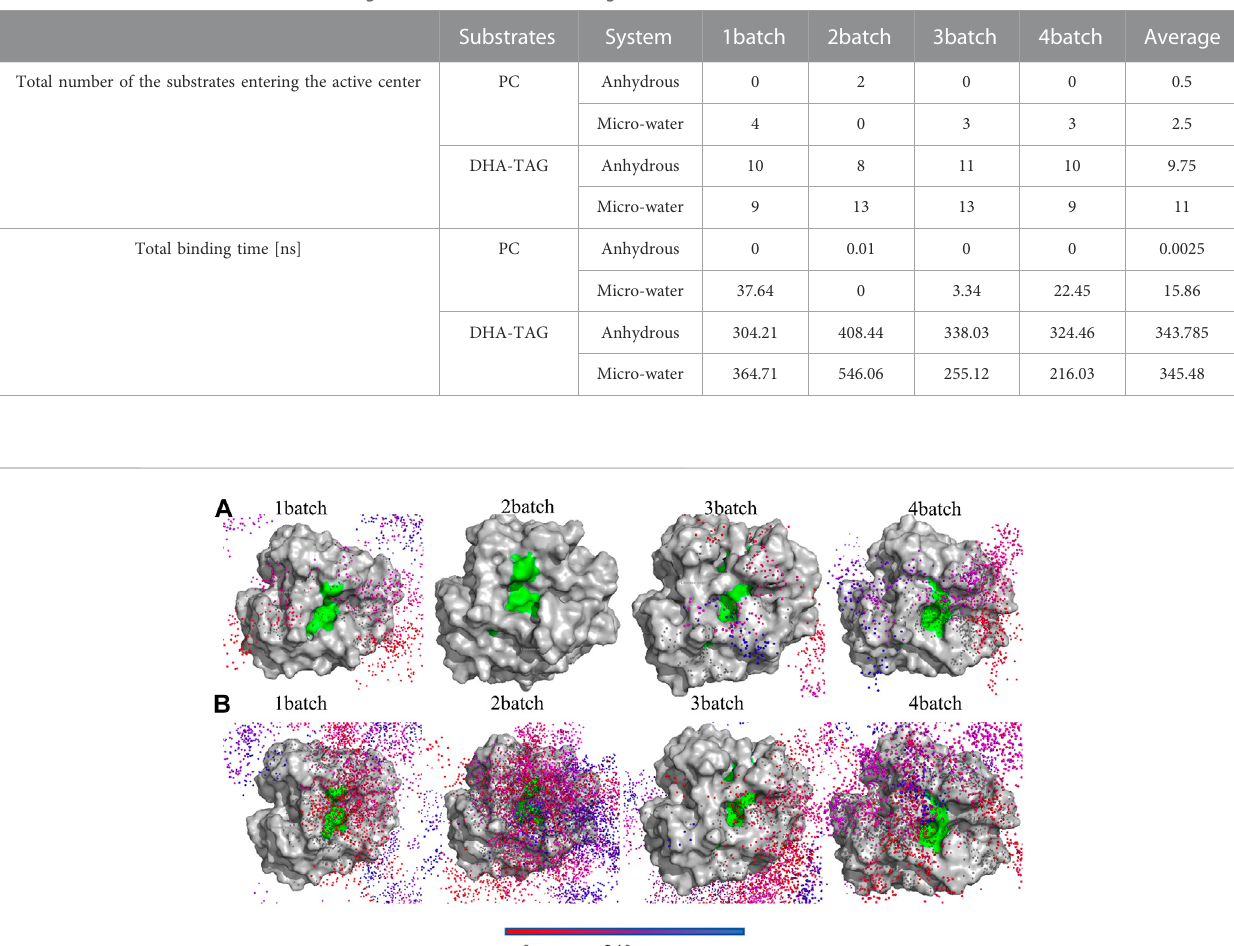
TABLE 3 The number of the substrates entering the active center and binding time.